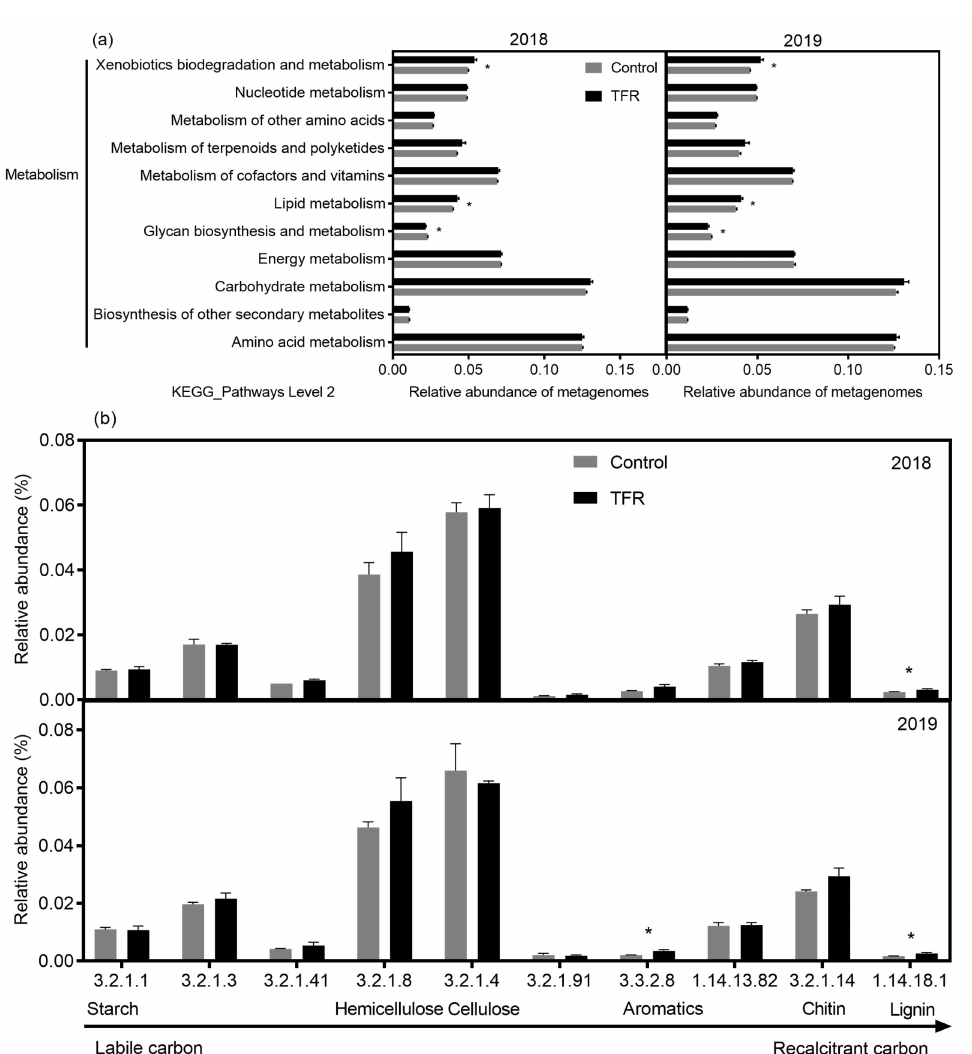
Figure 3. Relative abundance of the predicted bacterial genes of metagenome related to ( a ) KEGG pathways at level 2 and ( b ) the predicted exoenzymes for carbon degradation under different treatments in 2018 and 2019; * p < 0.05. Enzymes: 3.2.1.1, α -amylase; 3.2.1.3, glucan 1,4-a-glucosidase; 3.2.1.41, pullulanase; 3.2.1.8, endo-1,4-beta-xylanase; 3.2.1.4, cellulose; 3.2.1.91, cellulose 1,4-beta-cellobiosidase; 3.3.2.8, limonene-1,2-epoxide hydrolase; 1.14.13.82, vanillate monooxygenase; 3.2.1.14, chitinases; 1.14.18.1, monophenol